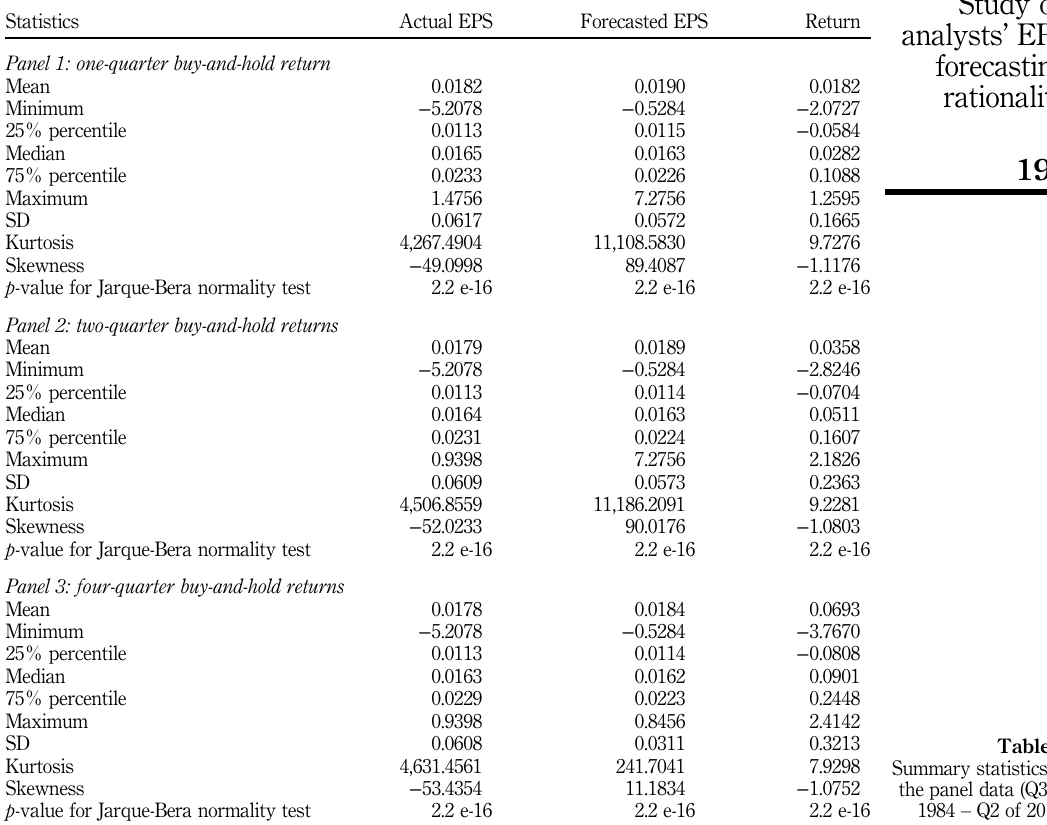
Table I. Summary statistics